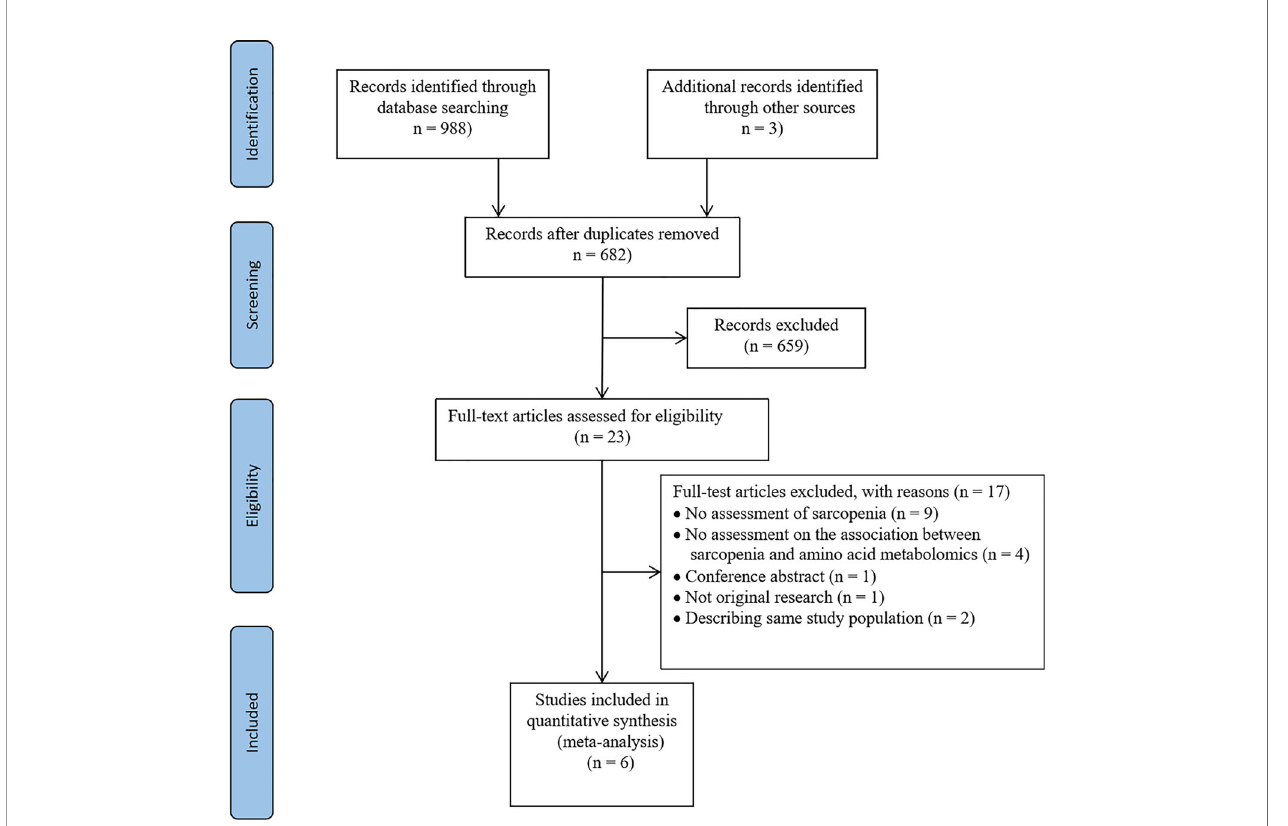
FIGURE 1 | Flow of the search strategy and included